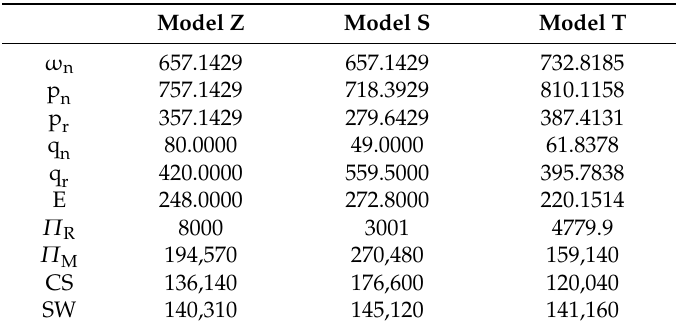
Table 2. The optimal decisions and profits in the different